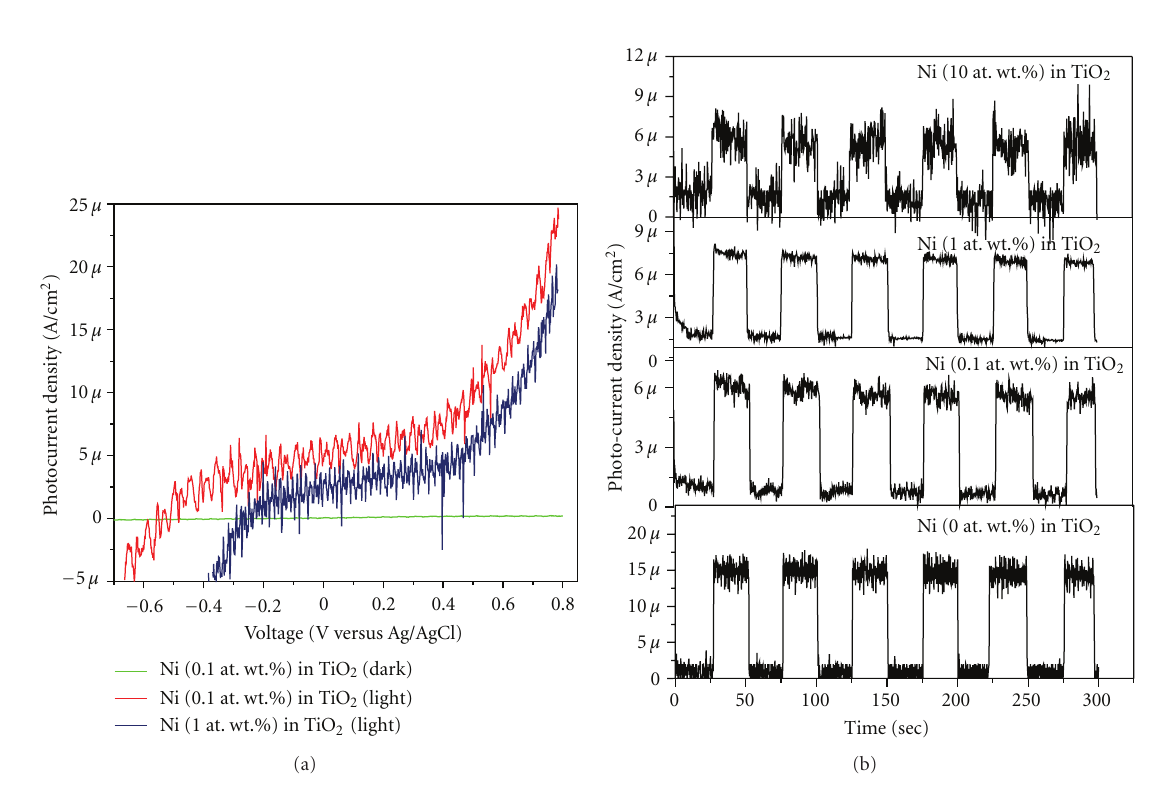
Figure 15: (a) Current-potential curves for photoelectrodes prepared from Ni-doped TiO 2 (Ni = 0.1 and 1 at. wt.%) thin films formed at 550 ◦ C for 30min on fluorine doped tin oxide (F: SnO 2 , FTO) coated soda lime glass substrates and (b) their corresponding chronoamperometric currents at 0.4V (versus Ag/AgCl). Electrolyte: 1 M NaOH solution. Light wavelength: 350nm and power density 1.039 mW/cm 2